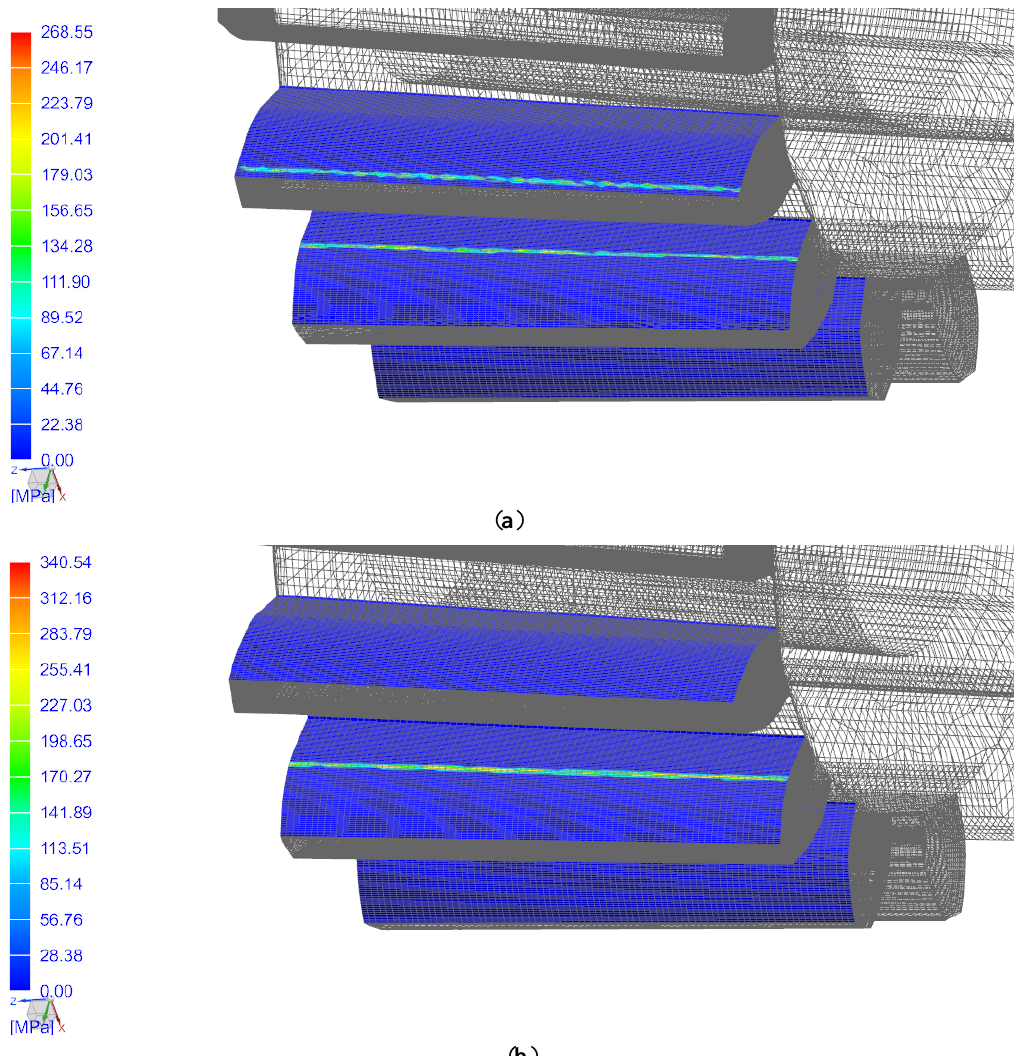
Figure 9. Contact patterns of two consecutive steps along the mesh cycle: ( a ) when two pairs of teeth are in contact; ( b ) when one pair of teeth is in contact.